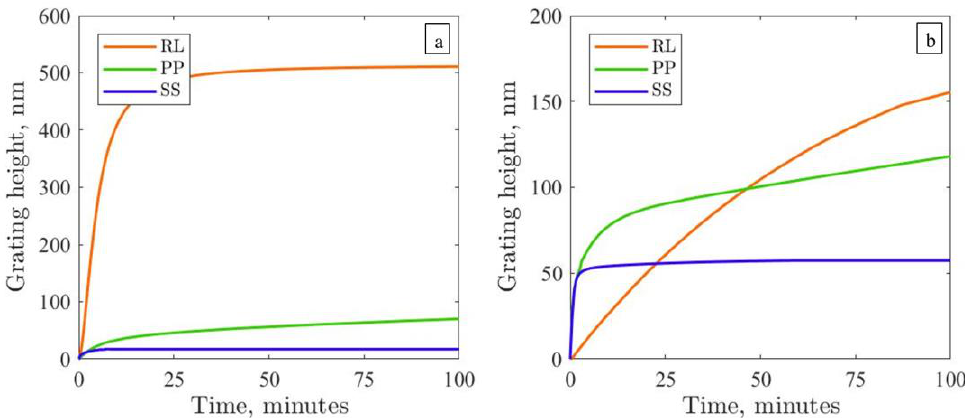
Figure 1. Experimentally recorded time-dependent growth of SS, PP and RL gratings for ( a ) pDR1 films of 500 nm thickness and ( b ) PAZO films of 1 µm thickness. The irradiation intensity in all cases is 100 mW/cm 2 , as measured at the sample; the irradiation wavelength is 491 nm; and the optical grating period is 2 µm.